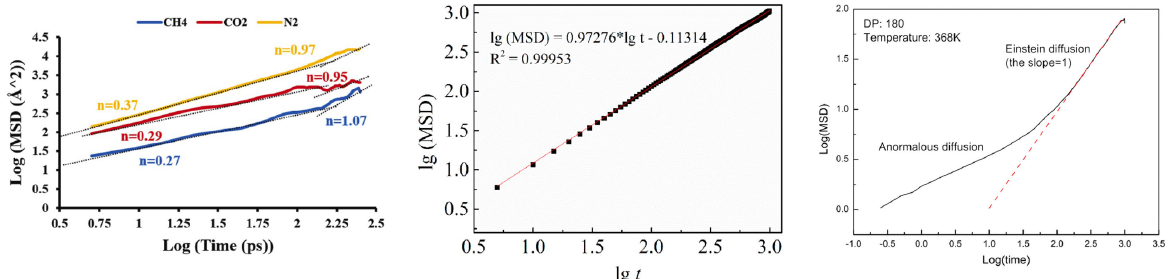
Figure 24. The mean square displacement of gas molecules in the membrane matrix [56,84,90].